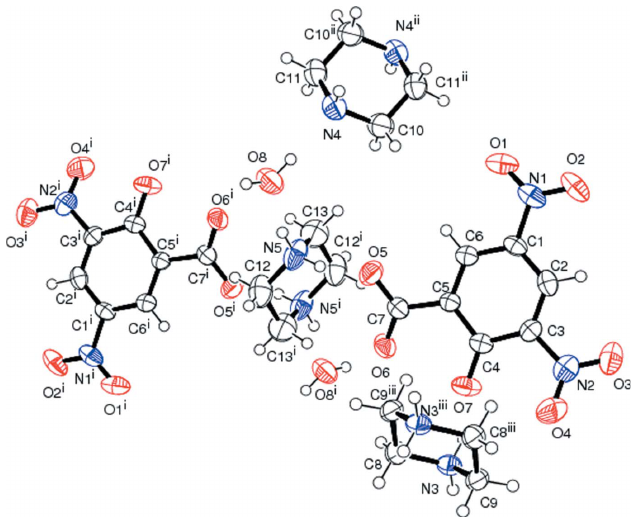
Figure 1 The molecular structure of the title adduct, (I), showing the atom- labelling scheme [symmetry codes: (i) (cid:2) x + 2, (cid:2) y + 2, (cid:2) z + 2; (ii) (cid:2) x + 1, (cid:2) y + 1, (cid:2) z + 2; (iii) (cid:2) x , (cid:2) y + 2, (cid:2) z + 1]. Displacement ellipsoids are drawn at the 50% probability